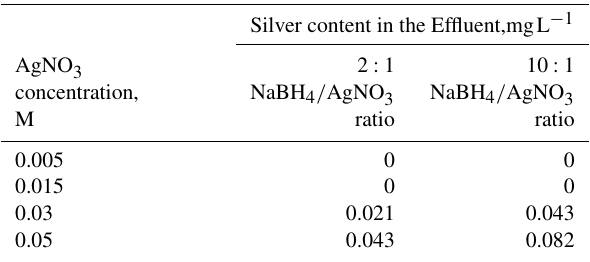
Figure 4. The removal efficiency of different types of bacteria with NaBH 4 / AgNO 3 ratio of 10 : 1: (a) E. coli . (b) Staphylococcus au- reus . (c) Enterococcus faecalis . (d) Enterobacter aerogenes and Klebsiella pneumoniae . (e) Proteus mirabilis . Table 4. The relationship between the silver content in the papers and silver in the effluent